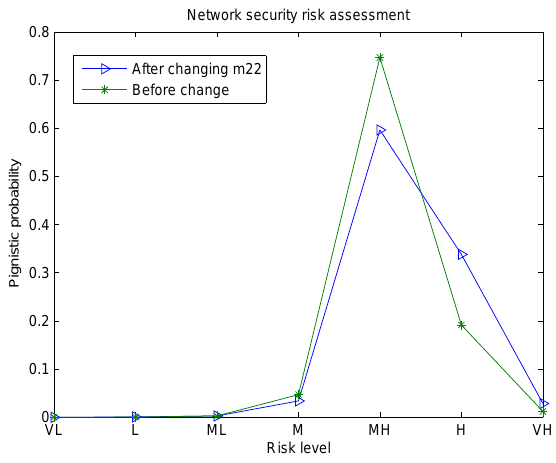
Figure 4. Comparison of evaluation results before and after changing m 15 .